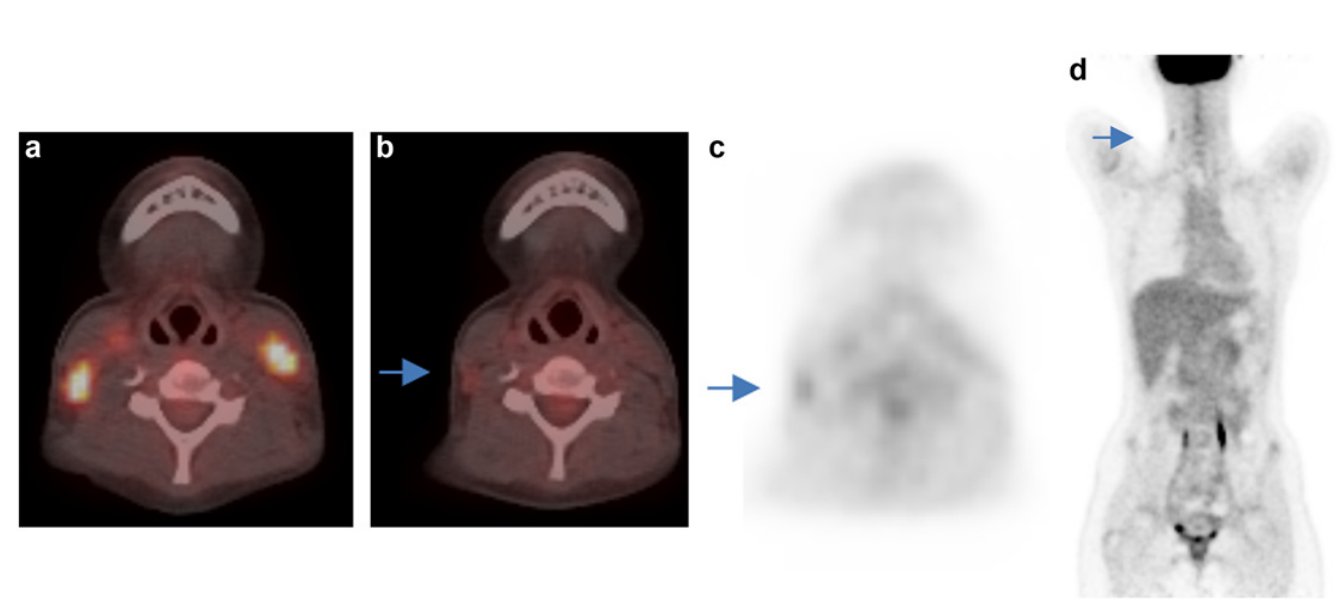
Fig 3. Discrepant D scoring of the neck region. Case 44: a) Lymphoma involvement at both sides of the neck before treatment. b) and c) residual lymph node on the right neck with slightly enhanced FDG uptake after to cycles ChT. d) The residual uptake is less than in the liver, but it is difficult to decide if it is above or below the MBP uptake. Deauville score of the readers R1-5, respectively: 2-3-3-1-3. Courtesy Dept. Clinical Physiology, Sahlgrenska University Hospital, Gothenburg Sweden.